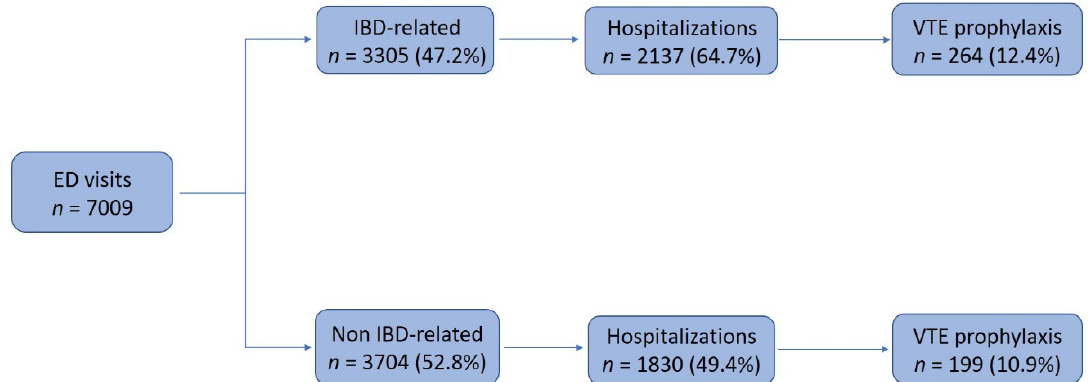
Figure 1. Distribution of all emergency department visits to IBD-related vs. non IBD-related admissions as well as hospitalizations and thromboprophylaxis administration rates.